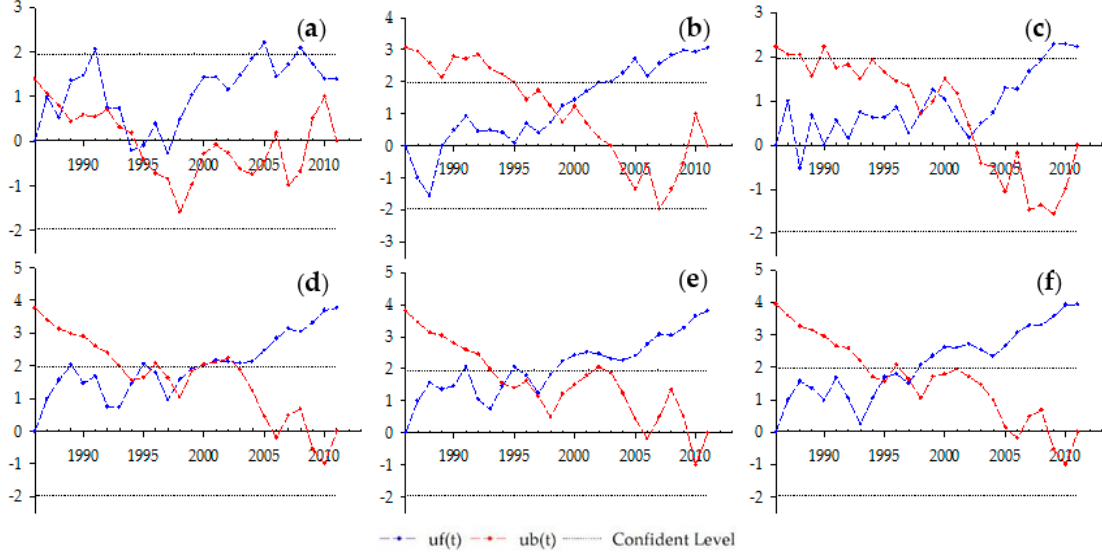
Figure 2. The sequential Mann-Kendall (SQ-MK) test to detect the trend shift points during 1986–2011 of ( a ) Growing season mean temperature (GST) for Qinghai-Tibet Plateau; ( b ) Growing season mean precipitation (GSP) for Tibet; ( c ) GSP for Qinghai; ( d ) GST for Qinghai-Tibet Plateau; ( e ) GST for Tibet; and ( f ) GST for Qinghai.